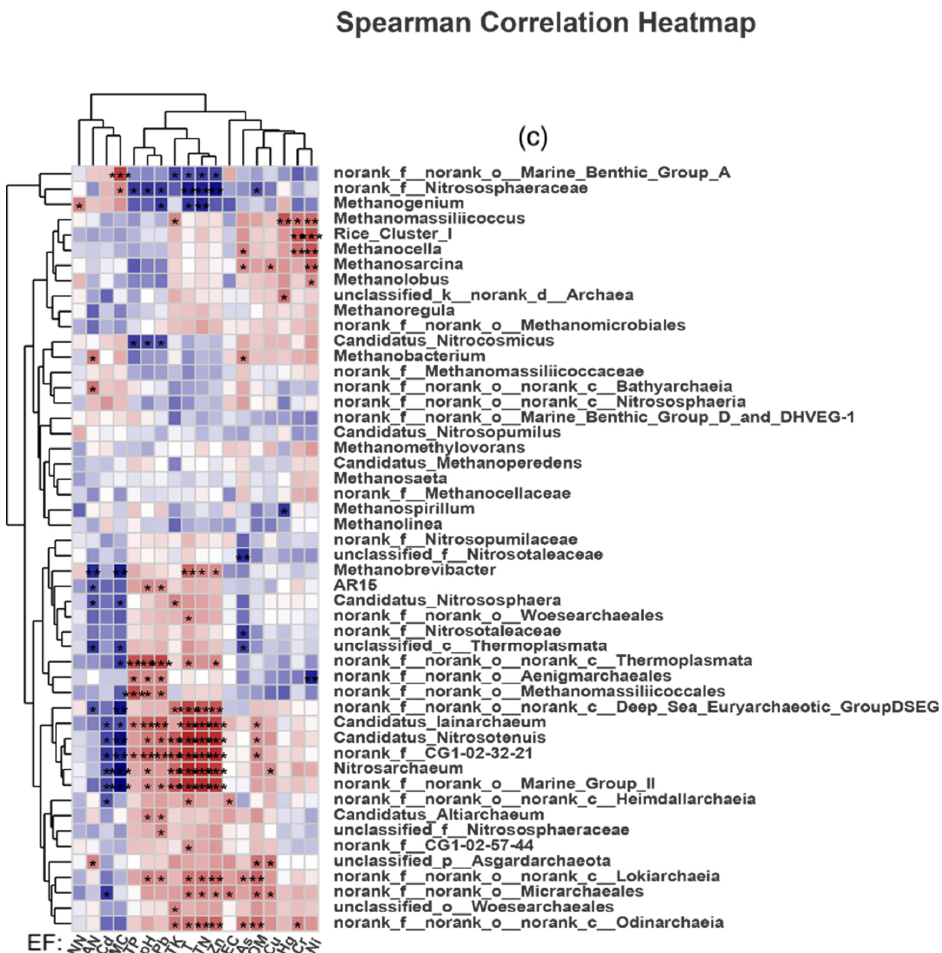
Figure 6. Heatmap of the correlation between environmental factors and microflora in different treatment groups: ( a ) CK group; ( b ) PM group; ( c ) OF group. EF, environmental factor. * Indicates (p < 0.05), ** indicates ( p < 0.01), *** indicates ( p < 0.001).